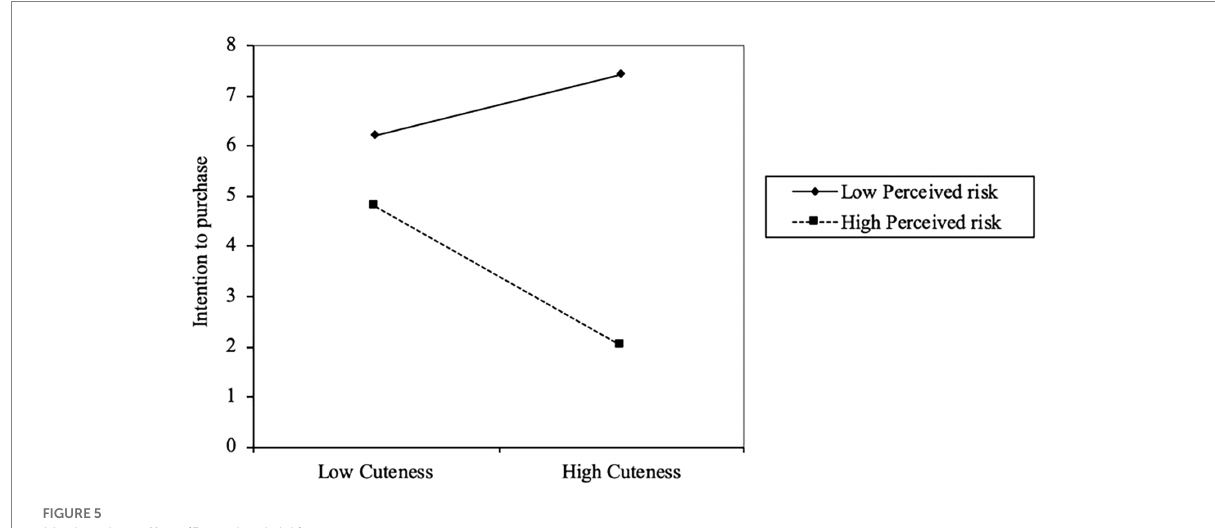
FIGURE 5 Moderating effect (Perceived